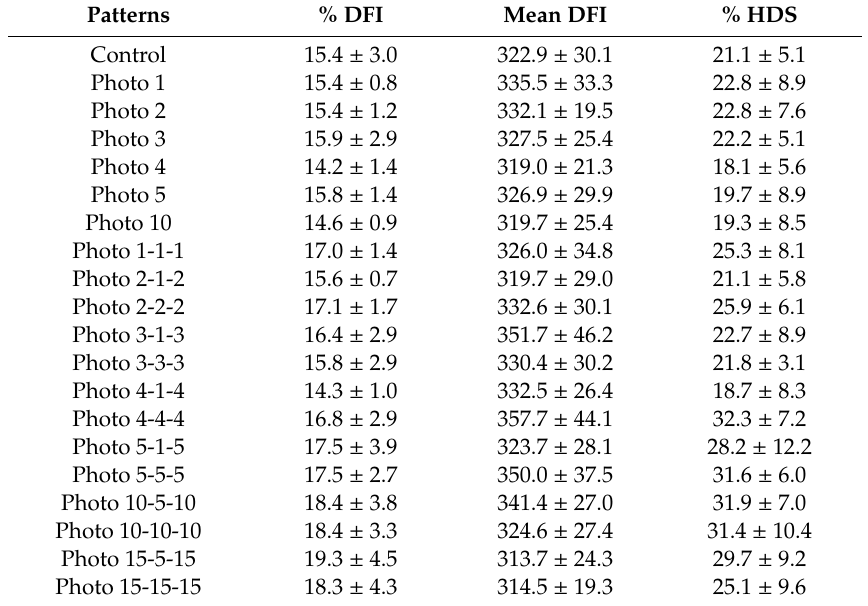
Table 3. DNA fragmentation parameters of horse sperm in control and irradiated samples. Data (mean ± SEM) are given as percentages of sperm with damaged chromatin (% DFI), mean fluorescence intensity of ssDNA (mean DFI), and percentages of high stainability (% HDS).